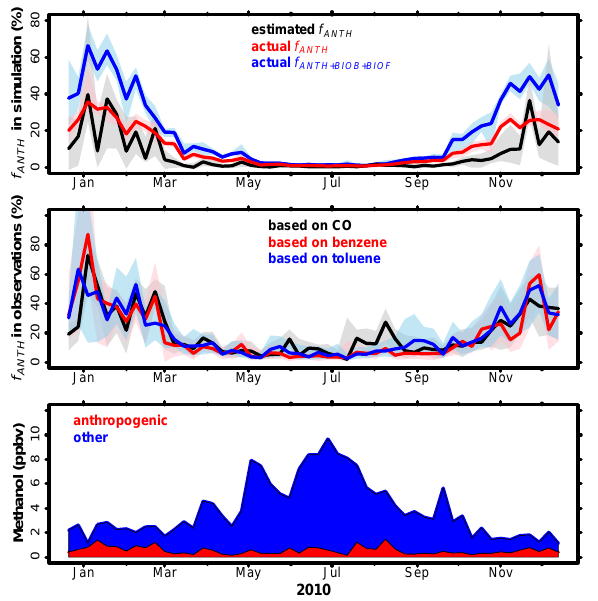
Fig. 5. Top panel: seasonal contribution of anthropogenic sources to simulated methanol abundance in GEOS-Chem. The black line shows the weekly median anthropogenic contribution estimated from the methanol: CO correlation as a test of the same approach applied to the observations. Also shown are the actual model con- tributions from anthropogenic emissions (red line) and from an- thropogenic emissions+biomass and biofuel burning (blue line). Shaded areas show the interquartile range in each case. Middle panel: seasonal anthropogenic contribution to methanol abundance at the KCMP tall tower estimated using different anthropogenic tracers (black: CO; red: benzene; blue: toluene). The shaded ar- eas represent the interquartile range about the weekly median. Bot- tom panel: stack plot of seasonal anthropogenic methanol concen- trations (red) at the KCMP tall tower estimated using CO as the an- thropogenic tracer (weekly median values). The blue area shows the cumulative contribution to the observed methanol abundance from other sources, including regional and transported biogenic emis- sions, photochemical production, fires, etc.